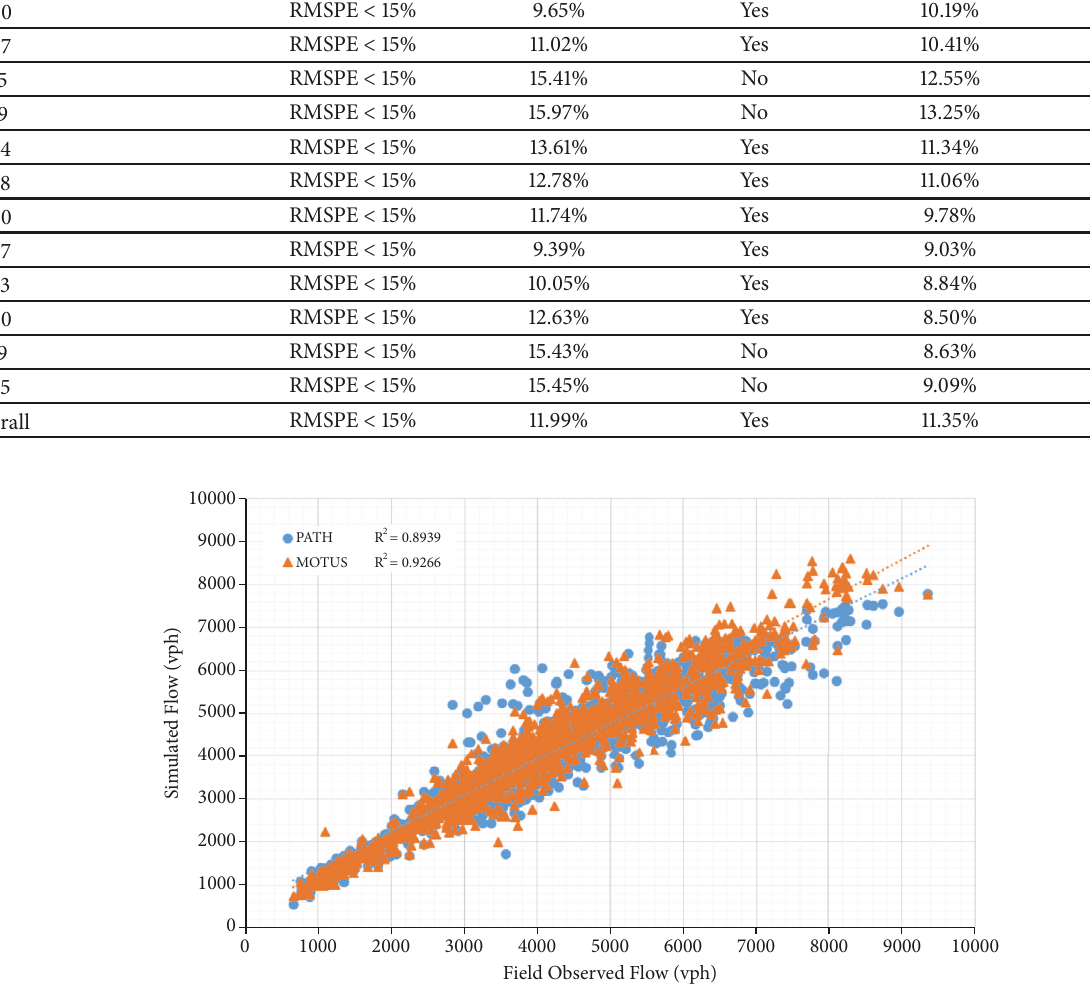
Figure 4: Scatter plot of simulated versus field observed